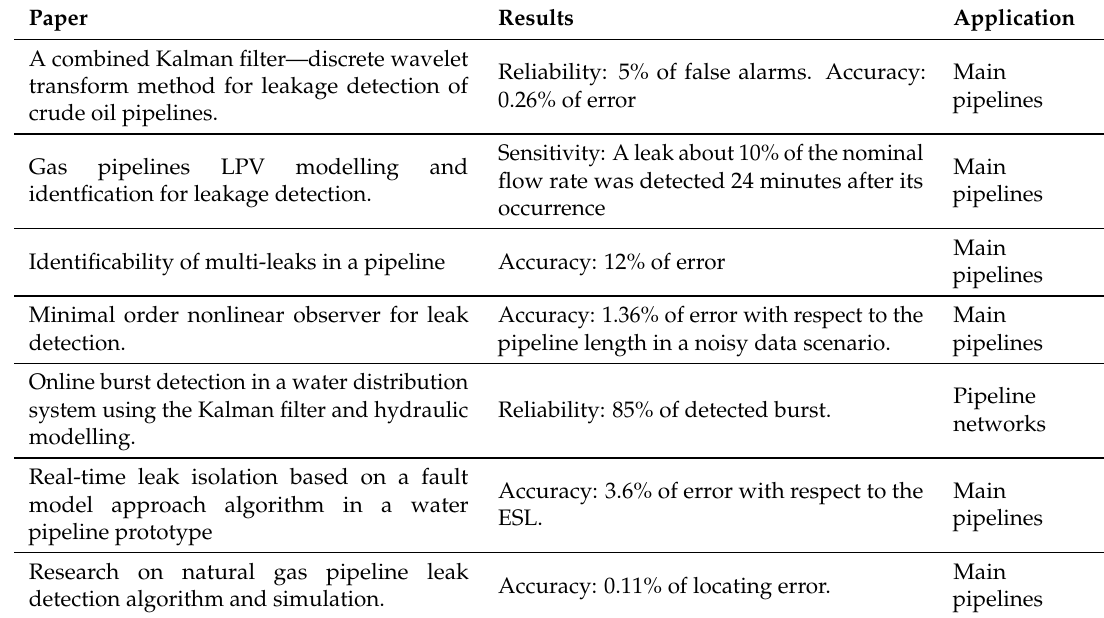
Table 3. Contributions with declared performance